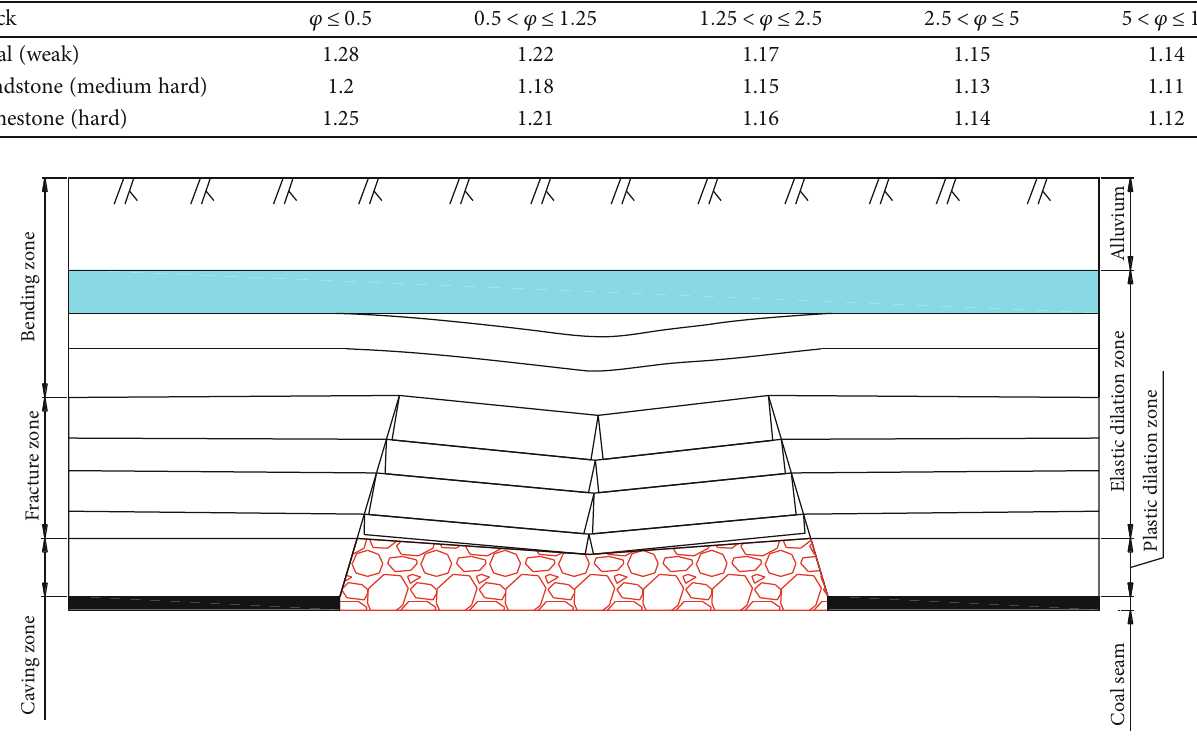
Table 4: Coe ffi cient of crushing and swelling of loose rock (coal).